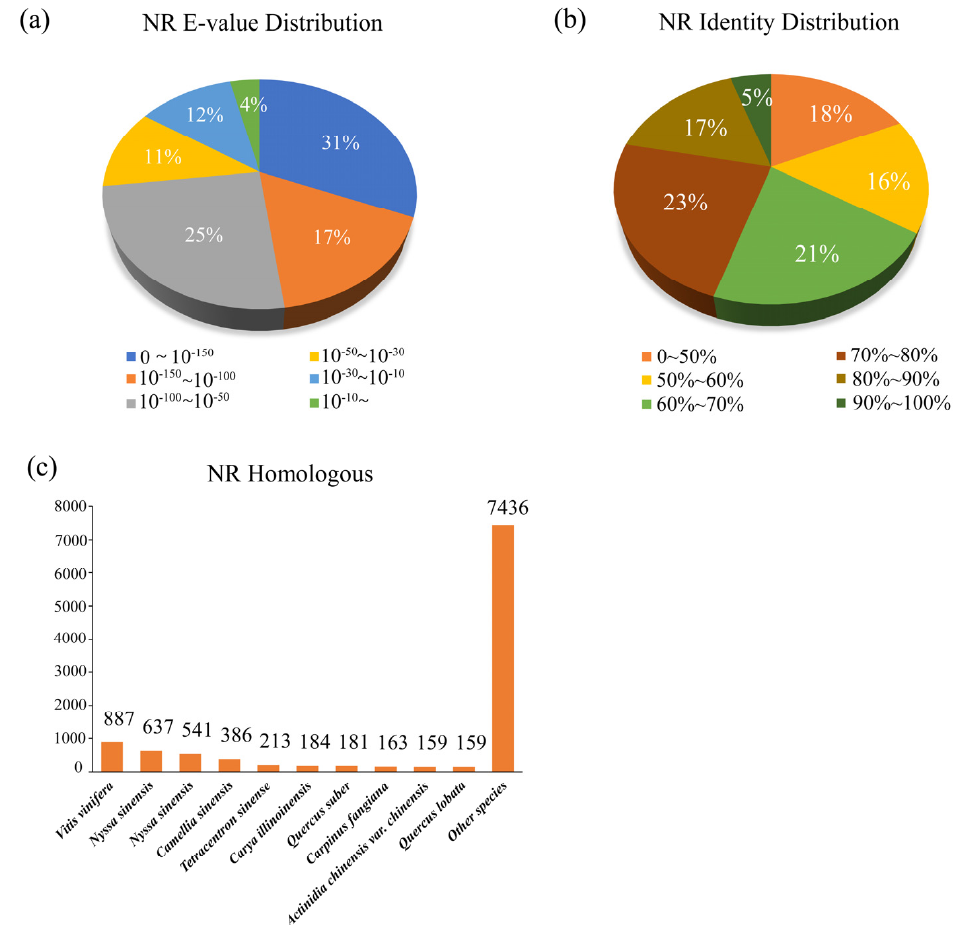
Figure 5. Homology searches of C. macrophyllum unigene and characteristics of non-redundant protein databases (Nr). ( a ) The E-value distribution of unigene BLASTx hits for every assembly. ( b ) BLASTx hit profiles for every assembly of unigenes. ( c ) Distribution of accessions hit by BLASTx at the top of each assembly of